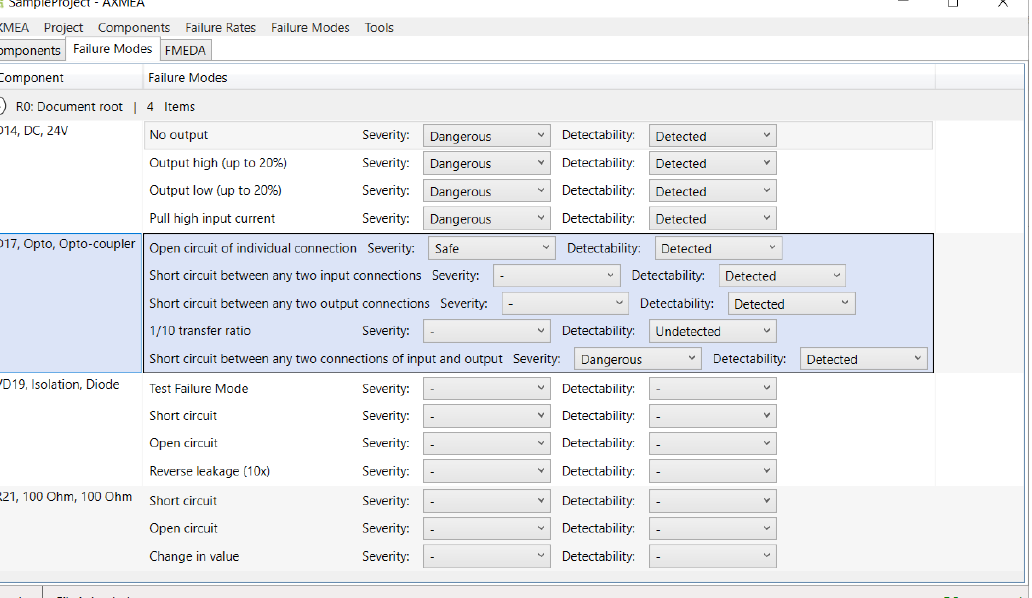
Figure 9. AXMEA tool: safety metrics calculation. AXMEA provides the possibility to generate reports on the work performed accord- ing to configurable templates that could be used as relevant project reliability and safety documentation. The reports include all the obtained metrics, used failure source database, and assessment process steps. 3.7.2. Assessment of Increasing Trustworthiness AXMEA tool allows to lower expert uncertainty by providing automation support of modes presented in Table 2. For example, the following modes could be supported by AXMEA in such a manner that allows eliminating dependence on expert decisions: